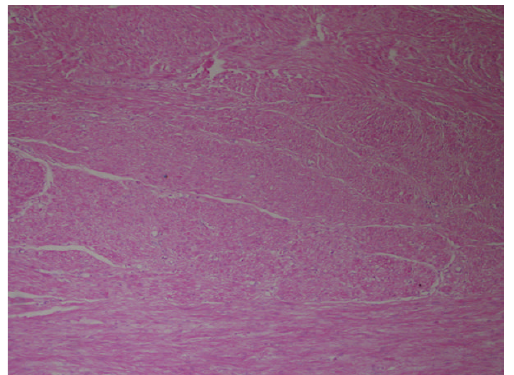
Figure 2: Microscopical view of hematoxylin-eosin stained